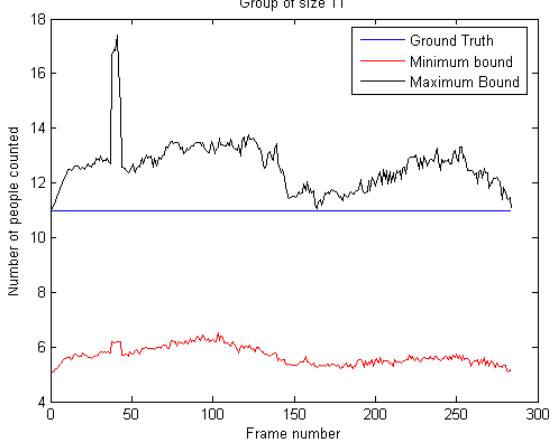
Figure 11: Plotting of exact counts over a group of 11 people in dance areas